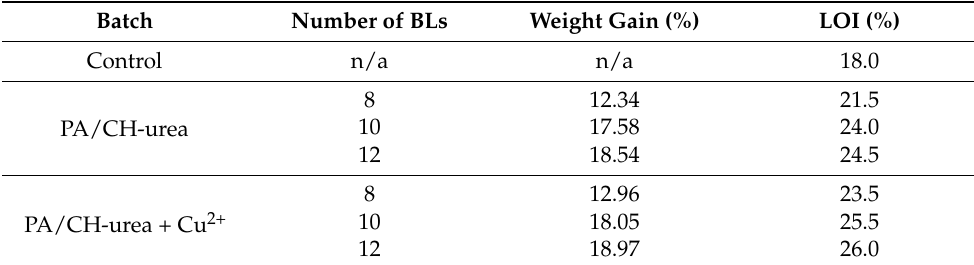
Table 1. Weight gain and LOI values of cotton coated with CH-urea/PA, with and without CuSO 4 . Batch